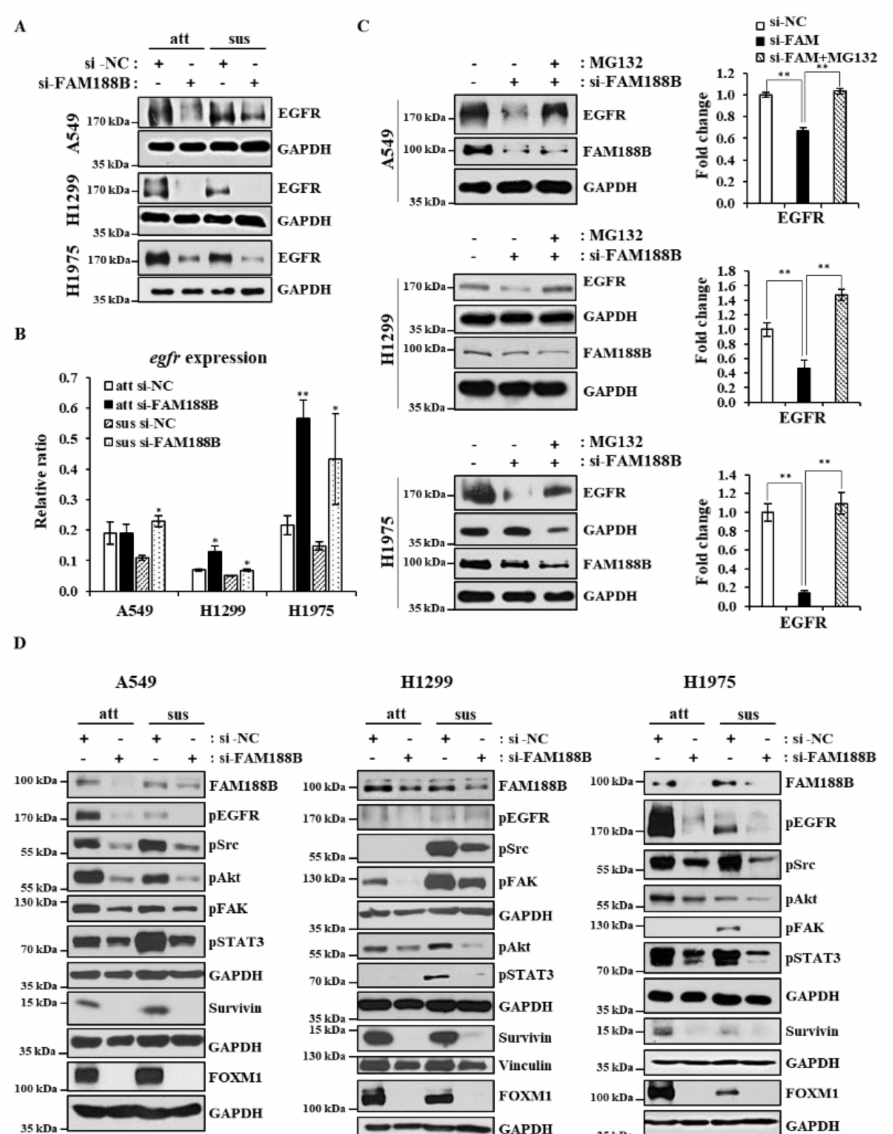
Figure 3. Effects of FAM188B knockdown on cell EGFR levels and survival signaling pathways. ( A , B , D ) Cells were transiently transfected with either si-NC or si-FAM188B for 48 h, followed by either attached or suspended culture for 24 h. Cells were then processed for immunoblot analysis using indicated antibodies. The levels of proteins were quantified by densitometry and normalized to GAPDH or Vinculin (Figure S3B–E) ( A , D ). qRT-PCR assay for relative EGFR mRNA expression levels ( B ). GAPDH was used as a loading control. ( C ) Cells were transiently transfected with either si-NC or si-FAM188B for 48 h and then treated with 20 µ M MG132 for 2 h before harvest. Cell lysates were processed for immunoblot analysis using indicated antibodies (left panel), and the levels of EGFR were quantified by densitometry and normalized to GAPDH (right panel). Error bars represent standard deviations of the mean of three measurements (* p < 0.05, ** p < 0.01). These experiments were performed three times independently with similar